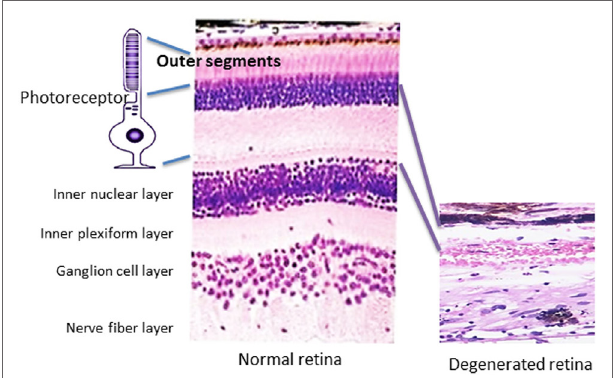
FigURe 1 | Pathology of retinal degeneration. A picture that illustrates a rod photoreceptor cell next to normal human retina (on the left) that is composed of several cell layers as follows: inner and outer segments of rod and cones of photoreceptors cells, outer nuclear layer, outer plexiform layer, inner nuclear layer, inner plexiform layer, ganglion cells layer, nerve fiber layer (axons of ganglion cells), and outer limiting membrane that neighbors with vitreous. A photograph of degenerated retina from a patient who lost completely photoreceptor cell layer (on the right), only inner part of the retina remained